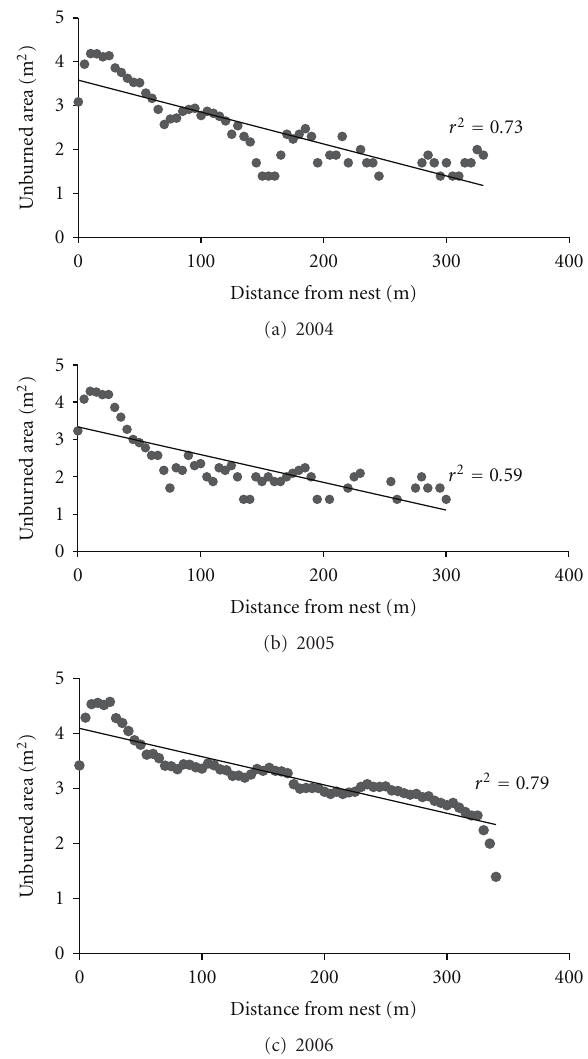
Figure 2: Relationship between unburned area and distance to nests in the 50 ha thrice-burned plot in a transitional forest near the Amazon-Cerrado boundary, N =